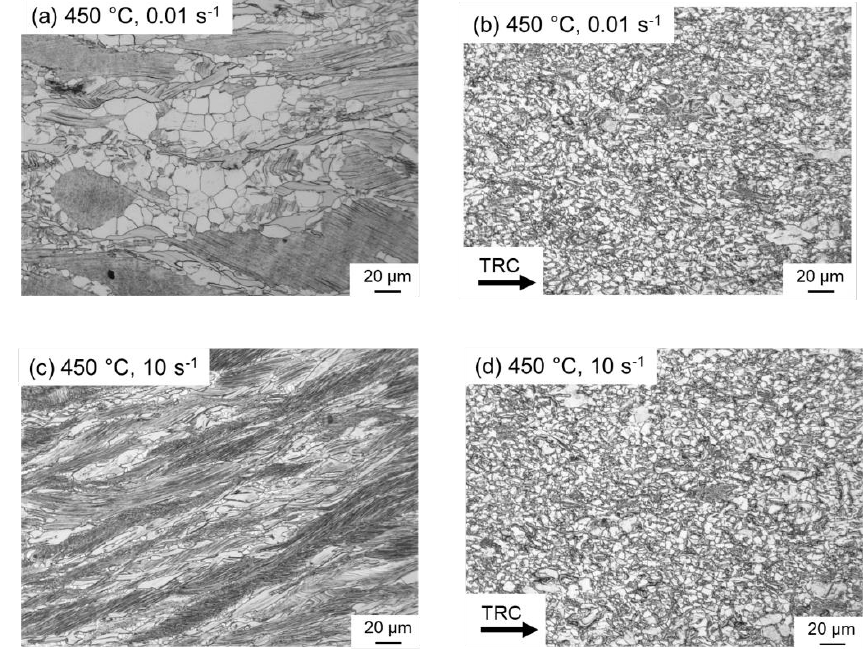
Figure 6 . Optical micrographs of the deformed samples of the Mg-6.8Y-2.5Zn-0.4Zr alloy after conventional ( a , c ) and after twin-roll casting ( b , d ) at 450 °C and strain rates of 0.01 s -1 ( a , b ) and 10 conventional ( a , c ) and after twin-roll casting ( b , d ) at 450 ◦ C and strain rates of 0.01 s − 1 ( a , b ) and s -1 ( c , d ) . 10 s − 1 ( c , d